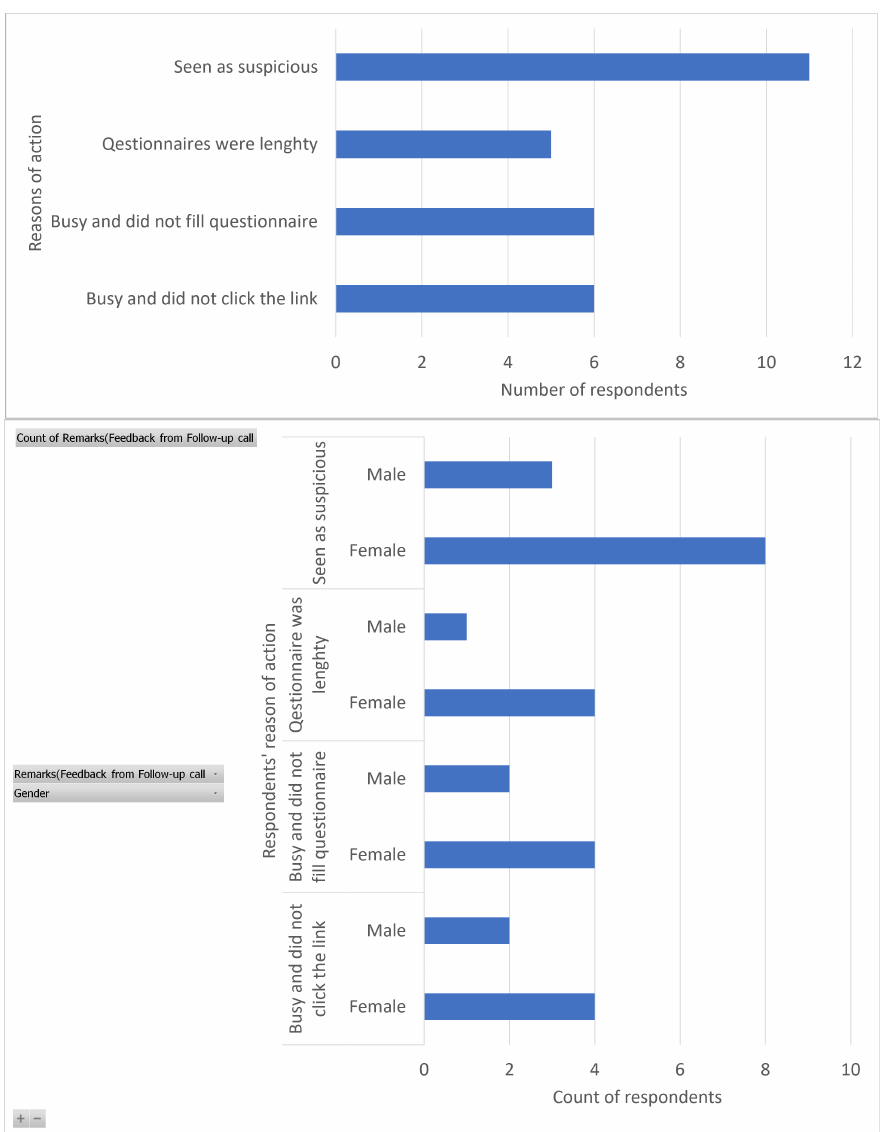
Figure 9. Feedback from respondents who fail to fill out the questionnaire and those who did not click on the